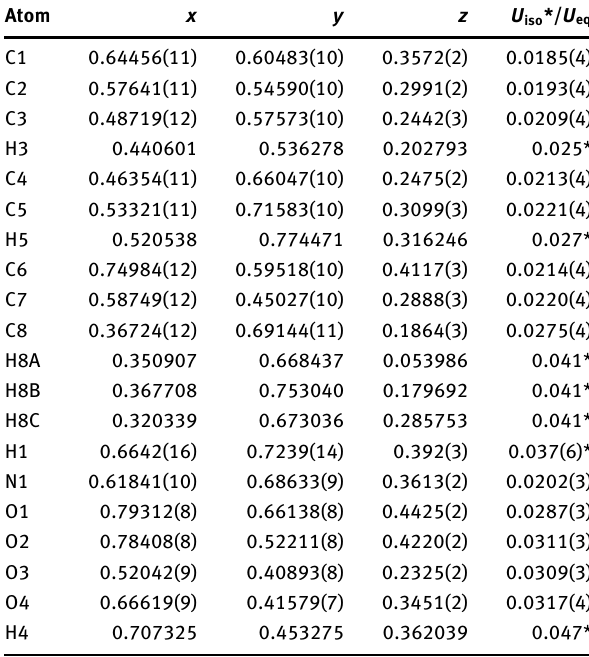
Table 2: Fractional atomic coordinates and isotropic or equivalent isotropic displacement parameters (Å 2